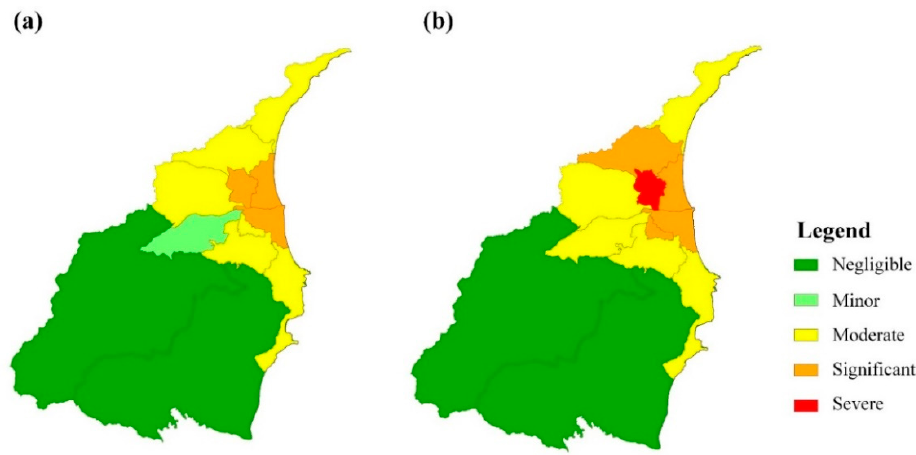
Figure 9. The risk assessment results for ( a ) the current and ( b ) the future scenarios by using the proposed algorithm of climate risk assessment based on Steps 2 and 3 of CCA6Steps.